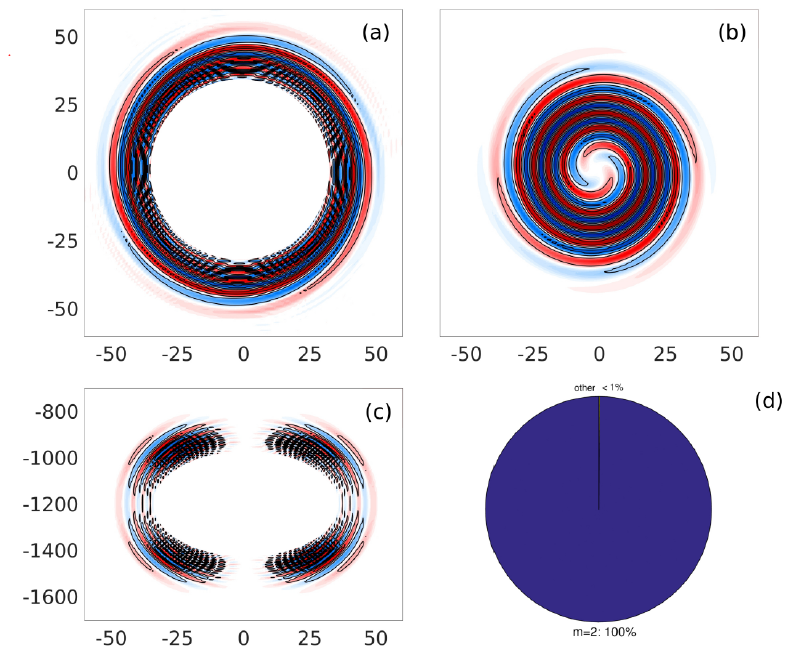
Figure 5. Optimal perturbation for the time interval τ = 174 days. ( a ) PVA horizontal section through the vortex core. ( b ) PVA section through the vortex lobes. ( c ) PVA vertical section. ( d ) Energy distribution on the azimuthal